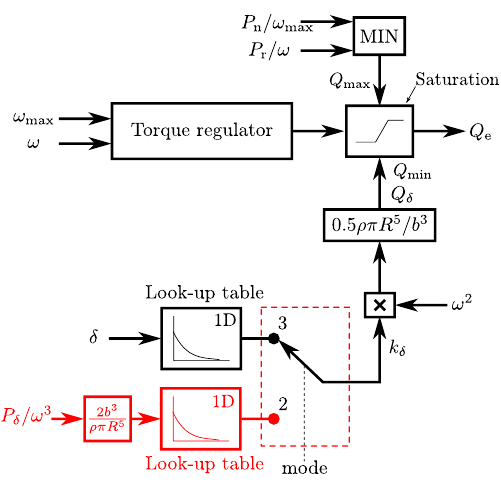
Figure 1. MPPT curve modification for delta control (our extension in red).